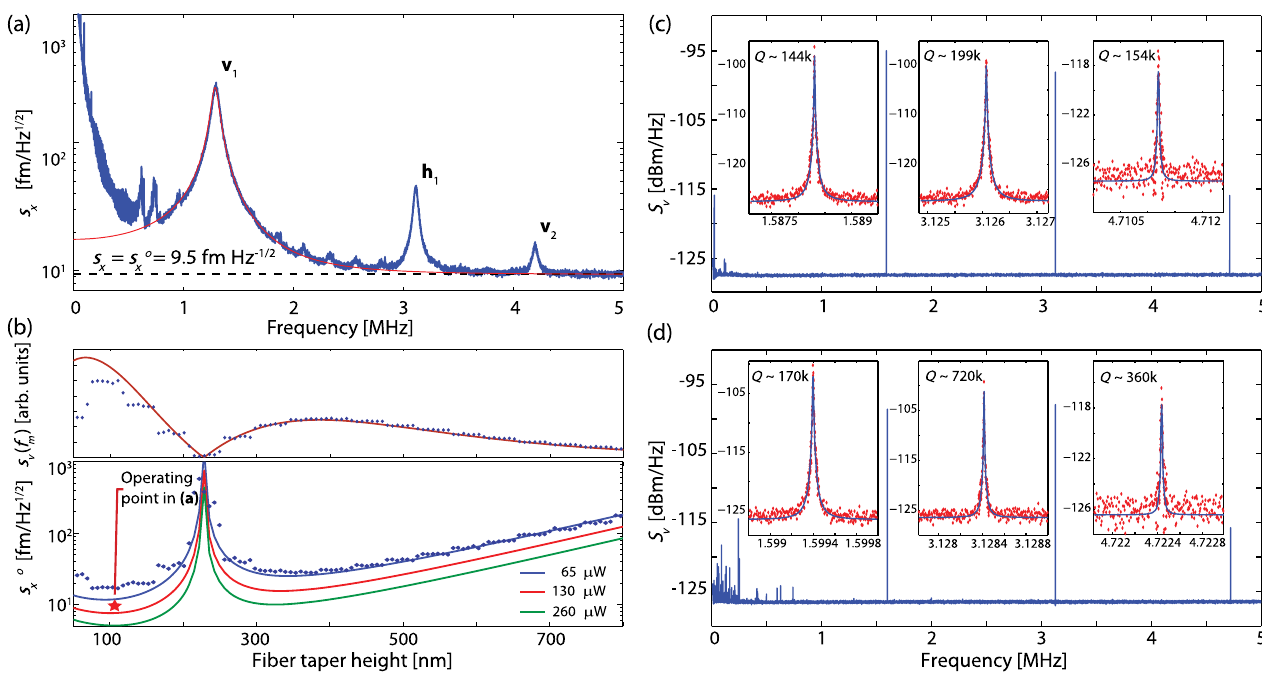
ð f Þ when the fiber taper is coupled to a nanobeam x ∼ 100 μ W. The vertical axis and noise floor (dashed line) of d